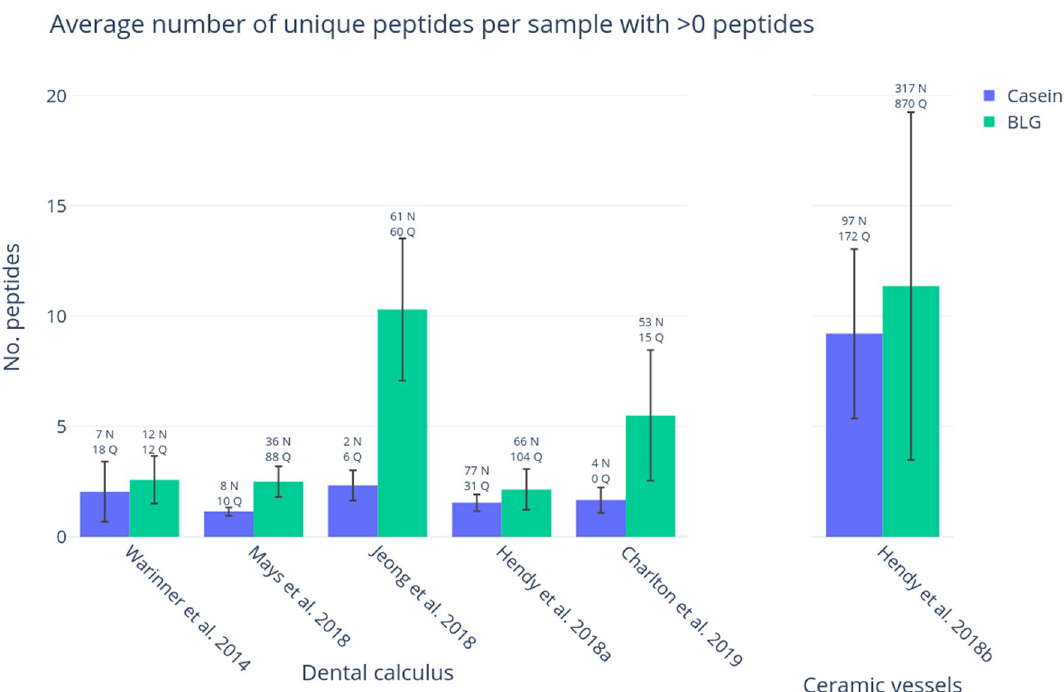
Figure 6. BLG and casein identifications in samples with at least one peptide in reanalysed datasets from previously published works. The average number of unique BLG and casein peptides is shown per sample in each study for samples that have at least one peptide. The error bars represent standard deviation. The summed total number of asparagine and glutamine residues attributed to any milk peptides for all sample in each study is shown above the error bars.